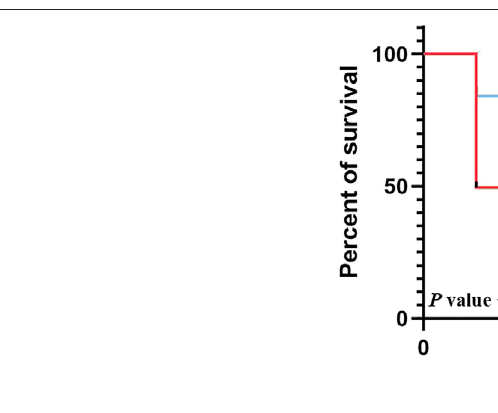
FIGURE 8 | The survival curve of A. purpuratus and A. irradians after ionizing radiation.